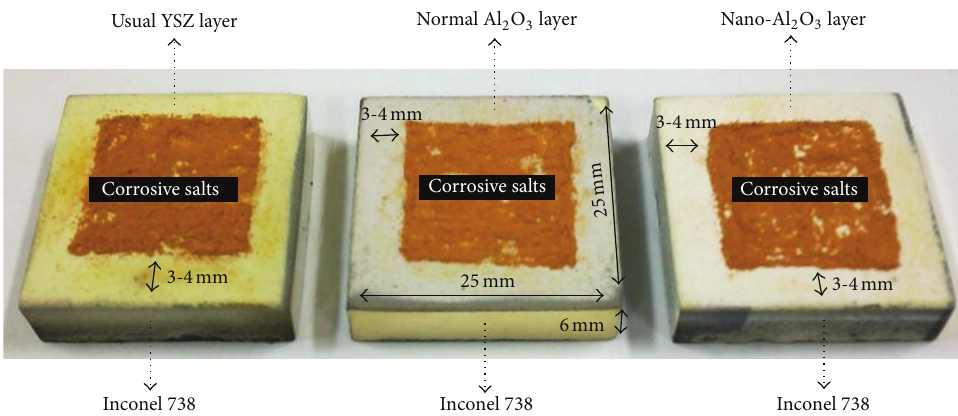
Figure 1: Taking care to stay within 3-4 mm from the edge, the coating surface was covered by 30 mg/cm 2 of powdery mixture, forming an even film of corrosive material (in order to prevent the effects of edge corrosion).